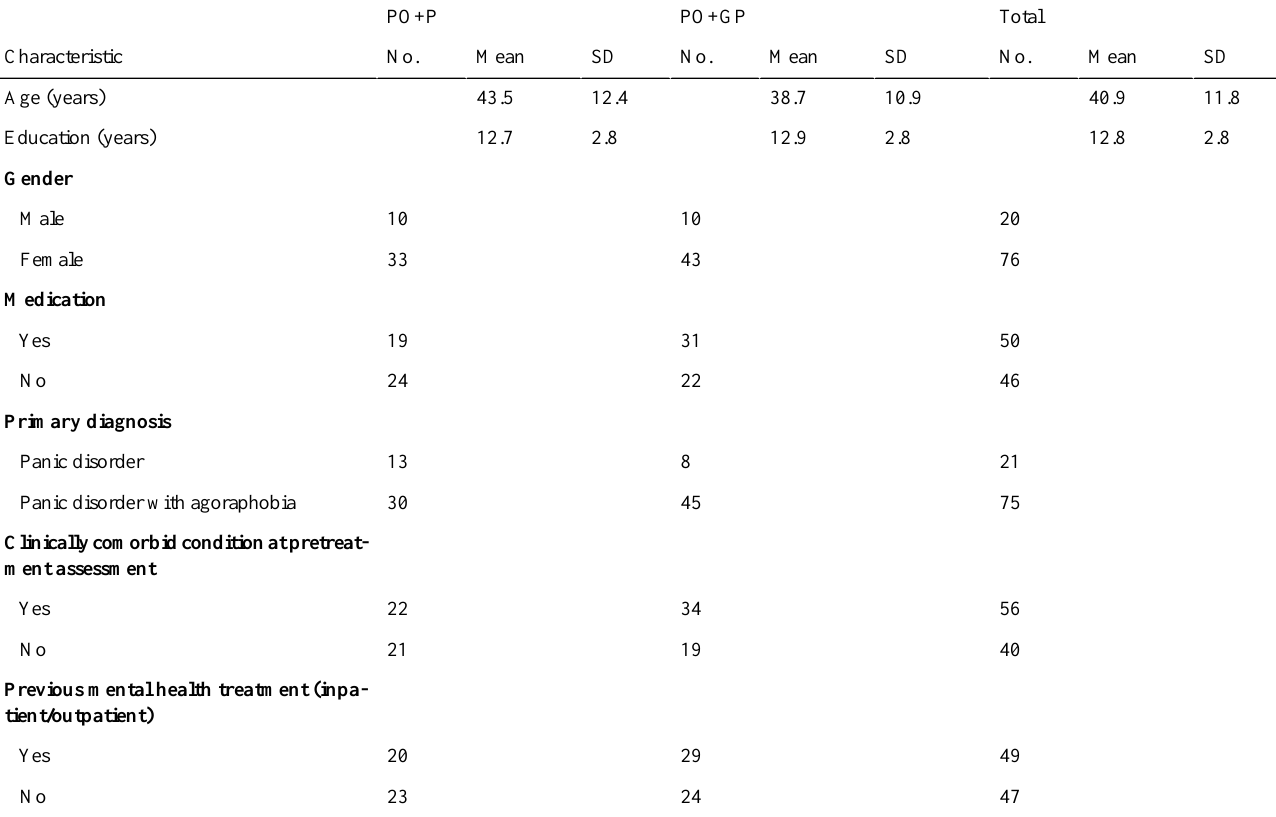
Table 1. Characteristics of participants at pretreatment assessment, by group